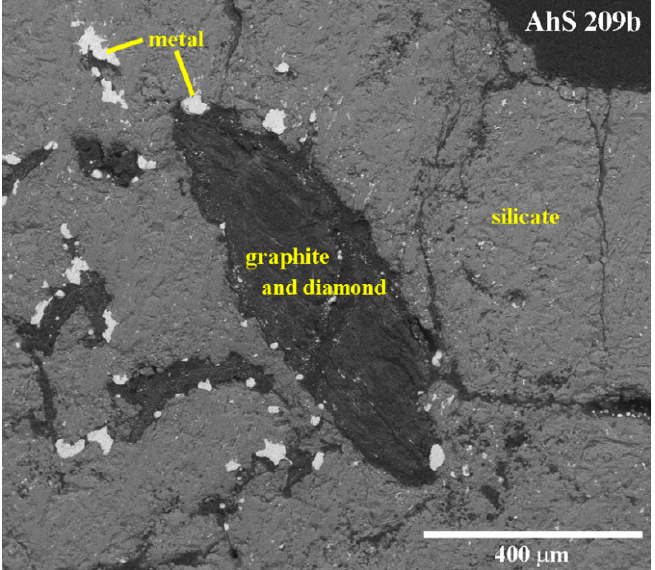
Figure 3. Carbon area in polished sections of AhS 209b. Back-scattered electron image (BSE) of the non-carbon-coated section of AhS 209b collected in low-vacuum mode.